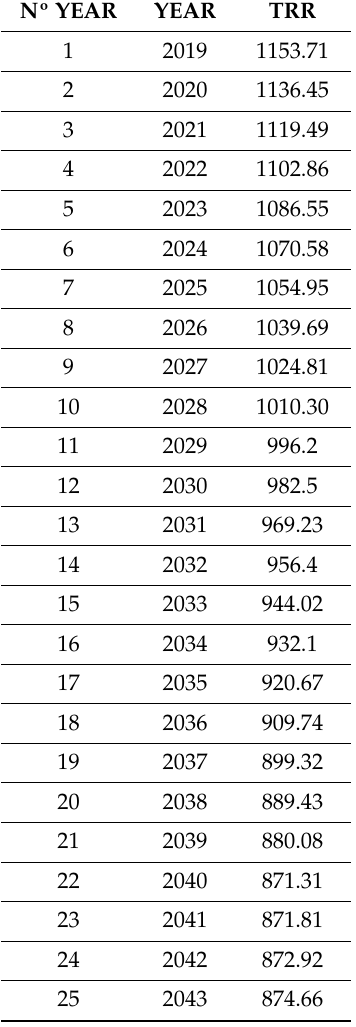
Table A9. Total revenue requirement of the plant (in millions of